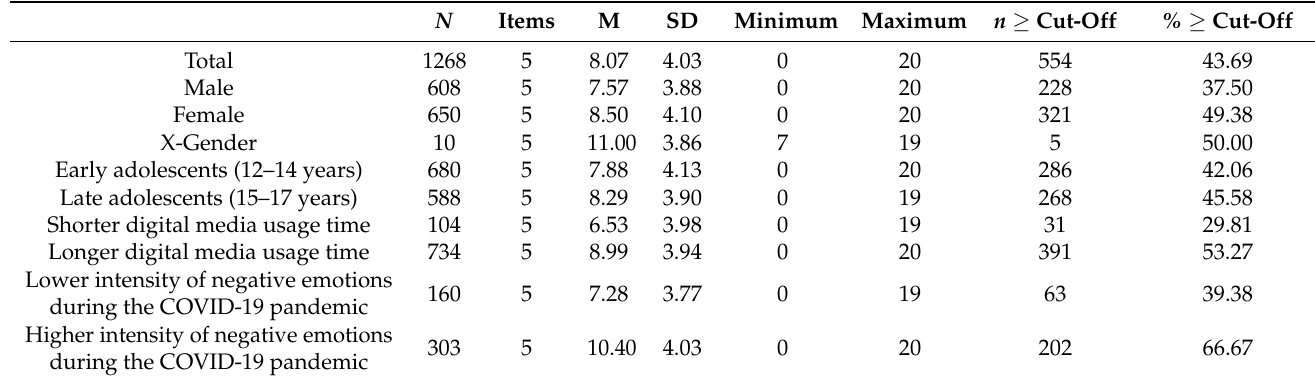
Table 4. Descriptive statistics of